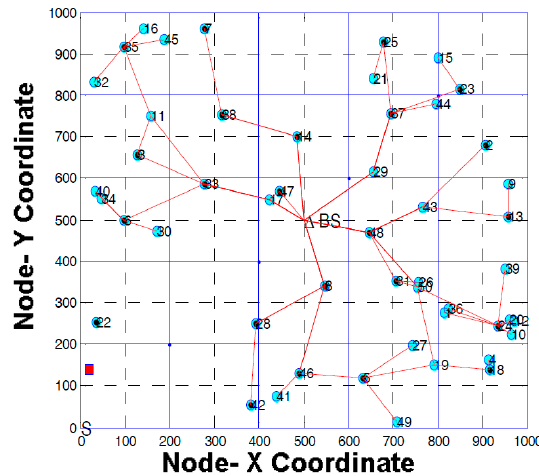
Figure 7. Grid clustering routing.